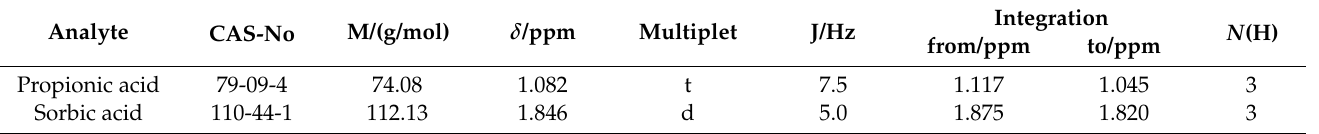
Table 5. Information for NMR quantification of sorbic and propionic